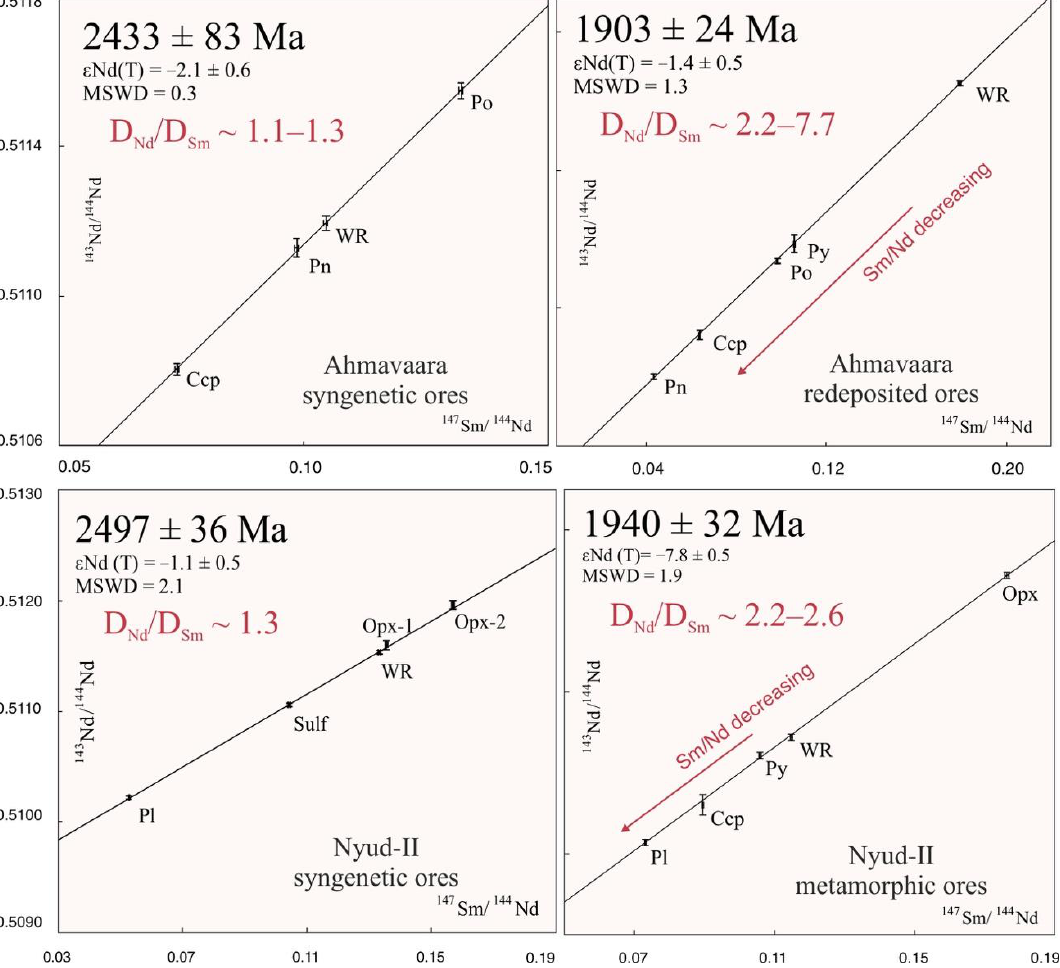
Figure 4. Mineral Sm-Nd isochrones for Ahmavaara and Nyud-II Cu-Ni deposits and D Nd /D Sm ratios for syngenetic and redeposited (or metamorphic) ores.